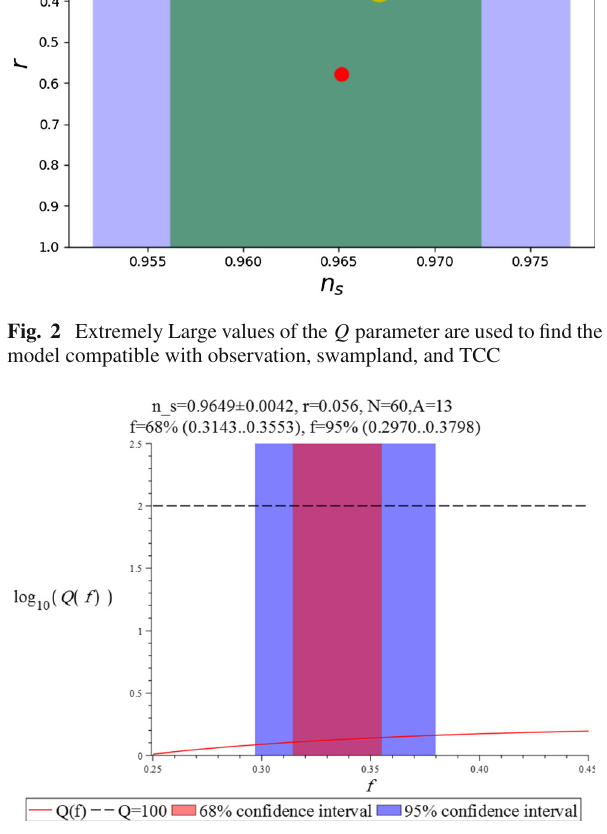
Fig. 3 In this figure, we fixed the number of e-folding and free param- eter A = 13. The colorful area between two red and black-dashed trajectories is compatible with just observation. The area upper than the black-dashed line is compatible with swampland and observation but not